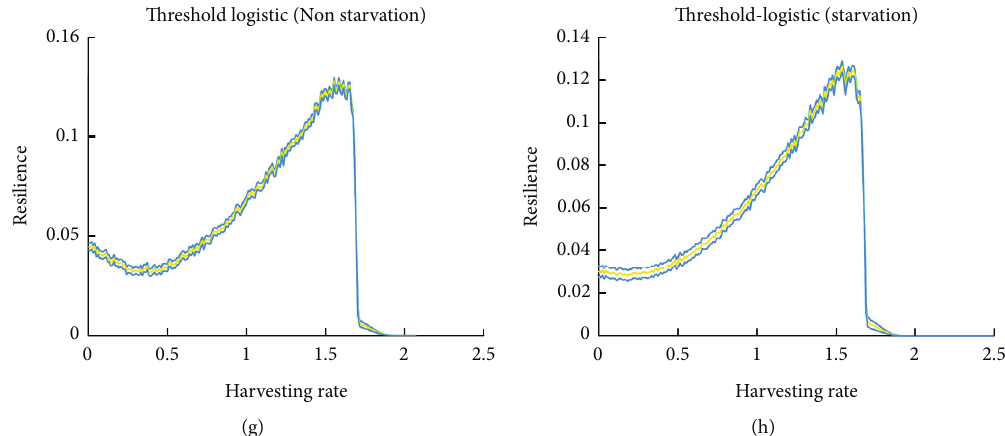
Figure 12: The resilience for semichemostat, logistic, semilogistic, and threshold-logistic stochastic growth rate with nonstarvation (a, c, e, g) and starvation (b, d, f, h). The mean (yellow curve) and the standard deviation (68%) (light blue curves) of the resilience are shown for all models. The detail explanation for the simulation can be seen in Section